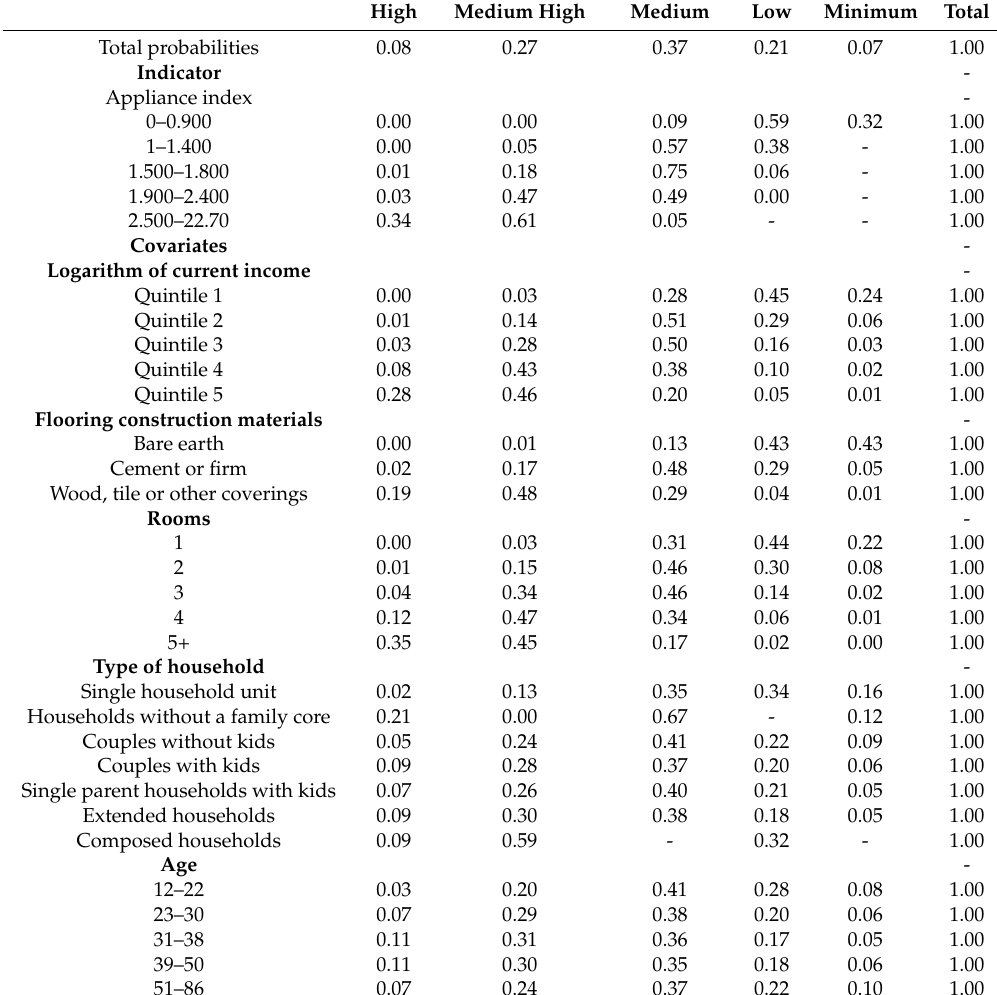
Table A4. Conditional probabilities for consumer practices latent class membership. Mexico,